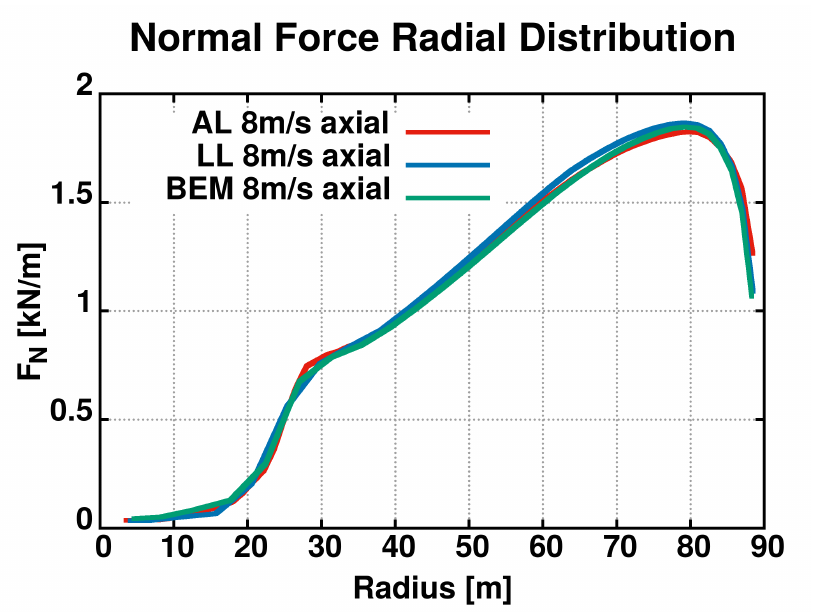
Figure 19. Normal force radial distribution at 8 m/s axial wind speed. Averaging over the final revolution of the simulation.